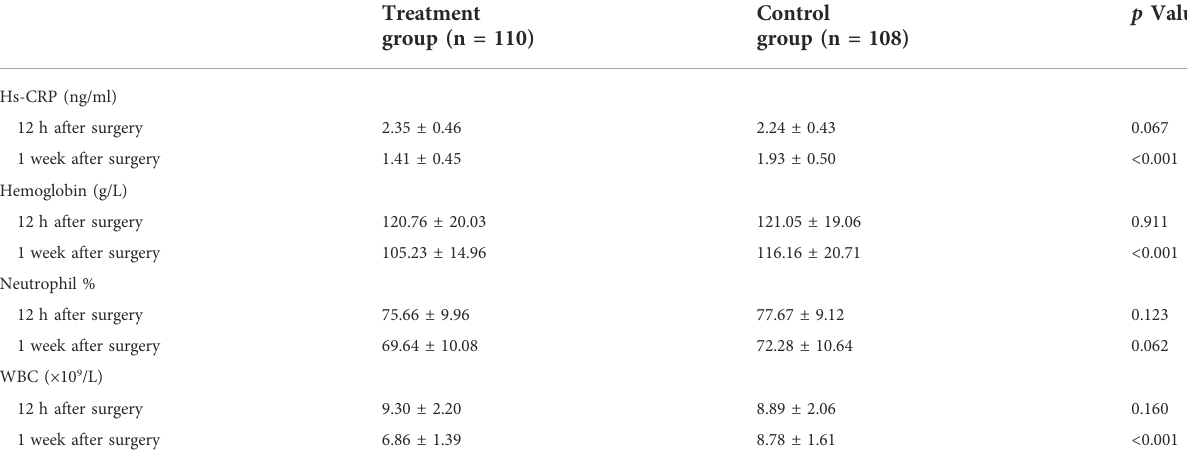
TABLE 4 Comparison of in fl ammatory factor levels between two